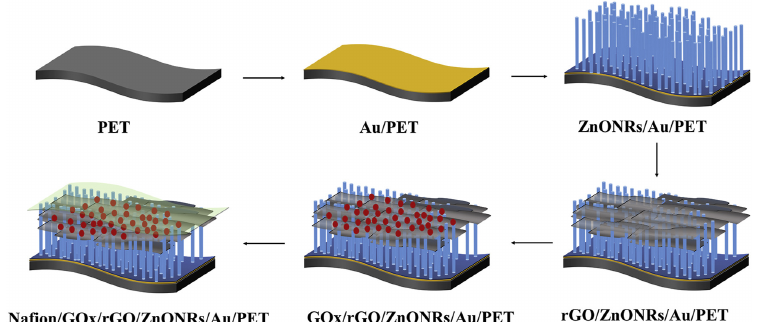
Figure 2. Schematic illustrating the steps of fabrication. Reprinted with permission from Ref.